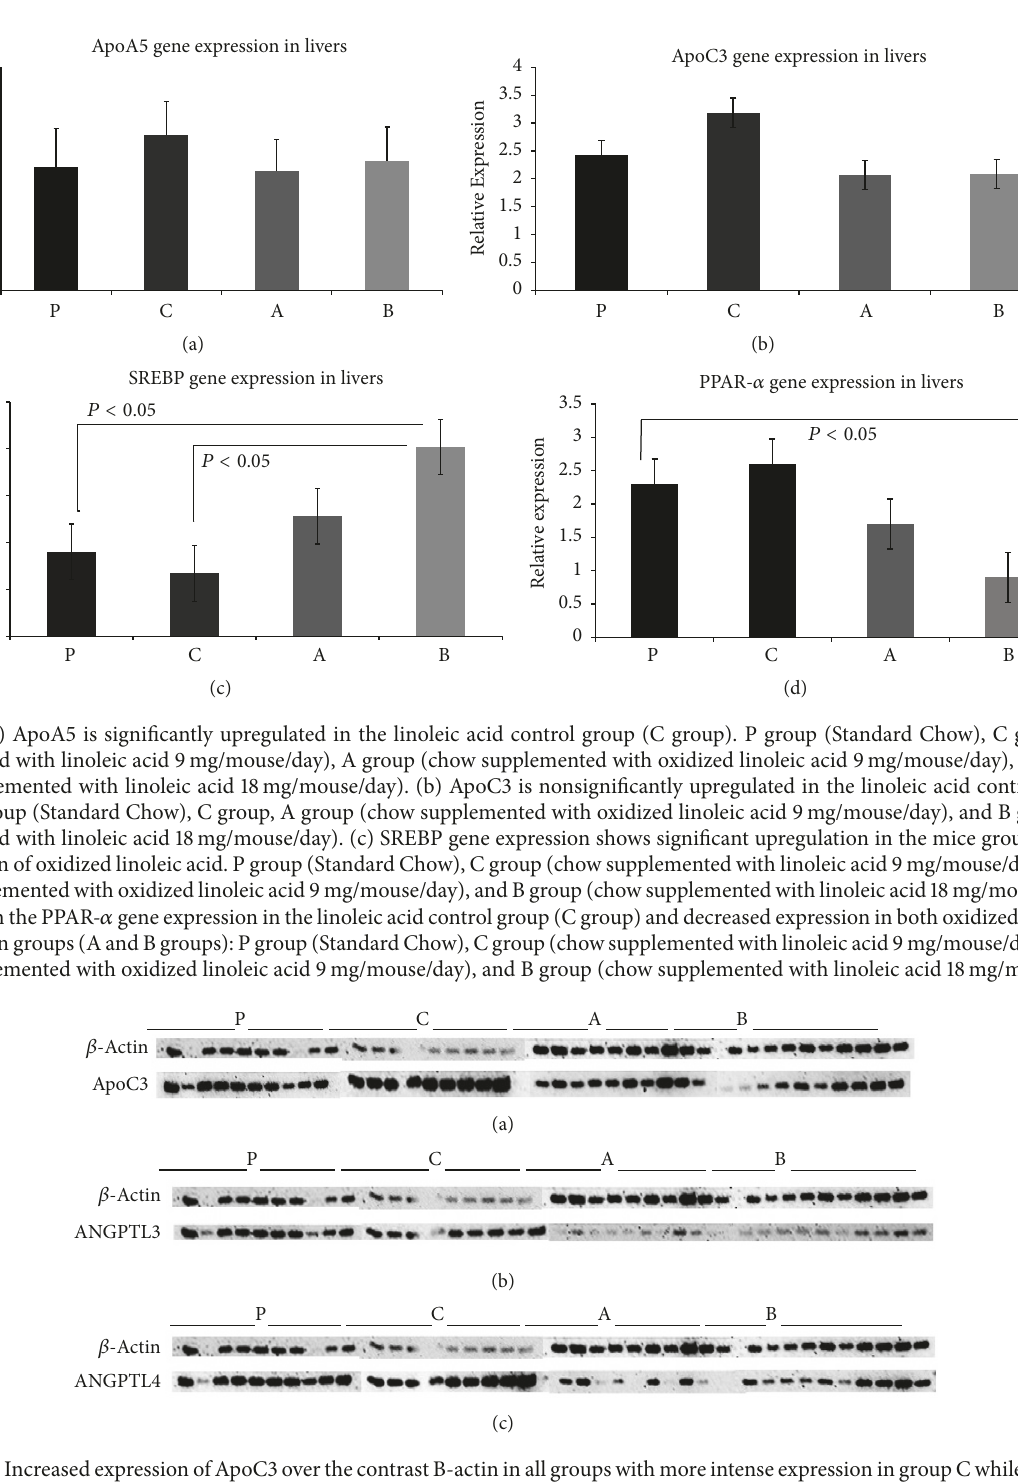
Figure 4: (a) Increased expression of ApoC3 over the contrast B-actin in all groups with more intense expression in group C while the B group seems unchanged. P group (Standard Chow), Cgroup (chow supplemented with linoleic acid 9 mg/mouse/day), Agroup (chow supplemented with oxidized linoleic acid 9mg/mouse/day), and B group (chow supplemented with linoleic acid 18 mg/mouse/day). (b) ANGPTL3 protein expression is increased in groups P and C, while it is underexpressed in groups A and B, with group showing much less expression. P group (Standard Chow), C group (chow supplemented with linoleic acid 9mg/mouse/day), A group (chow supplemented with oxidized linoleic acid 9mg/mouse/day), and B group (chow supplemented with linoleic acid 18 mg/mouse/day). (c) ANGPTL4 protein expression is increased intensely in groupC,as well as thePgroup, which also showsa slight increase. Group Ashowsno change inexpression levels whiletheBgroup displays much less expression between the dose dependent groups (A and B). P group (Standard Chow), C group (chow supplemented with linoleic acid 9mg/mouse/day), A group (chow supplemented with oxidized linoleic acid 9mg/mouse/day), and B group (chow supplemented with linoleic acid